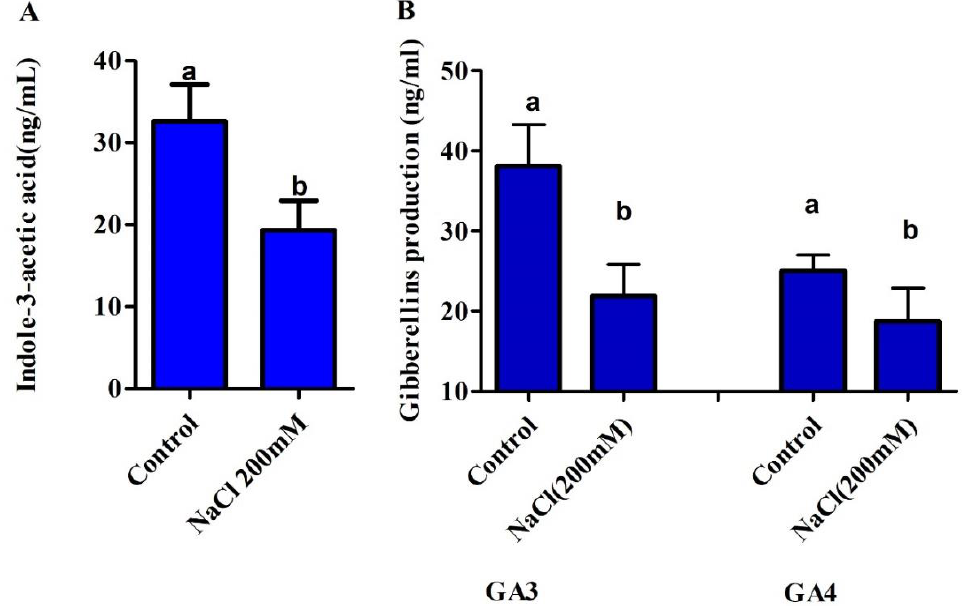
Figure 2. Amount of indole-3-acetic acid IAA ( A ) and gibberellic acid (GA) production ( B ) in culture broth of isolate CS51 in regular Luria-Bertani(LB) media and LB media spiked with NaCl. Each value represents the mean ± SD of three replicates. Different letters on columns with error bars (mean ± SD) represent a significant difference among the treatments evaluated by Duncan’s Multiple Range Test (DMRT).